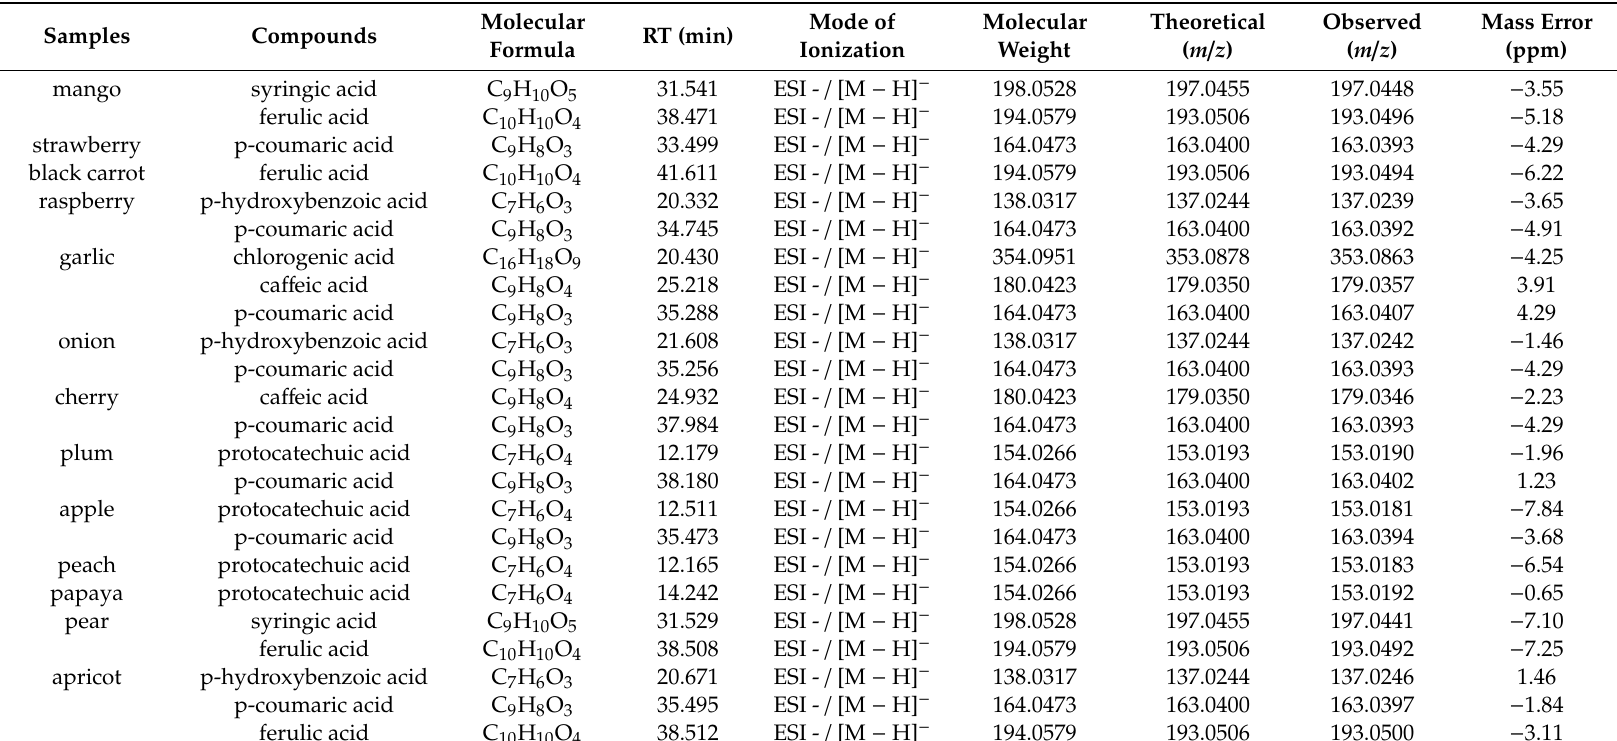
Table 4. Polyphenol compounds detected and identified in LC-ESI-QTOF / MS (only) for each plant